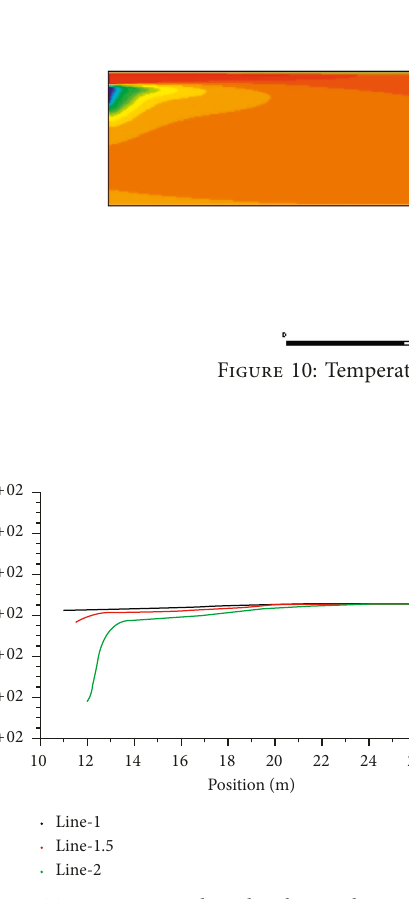
Figure 11: Temperature at three heights in the roadway.